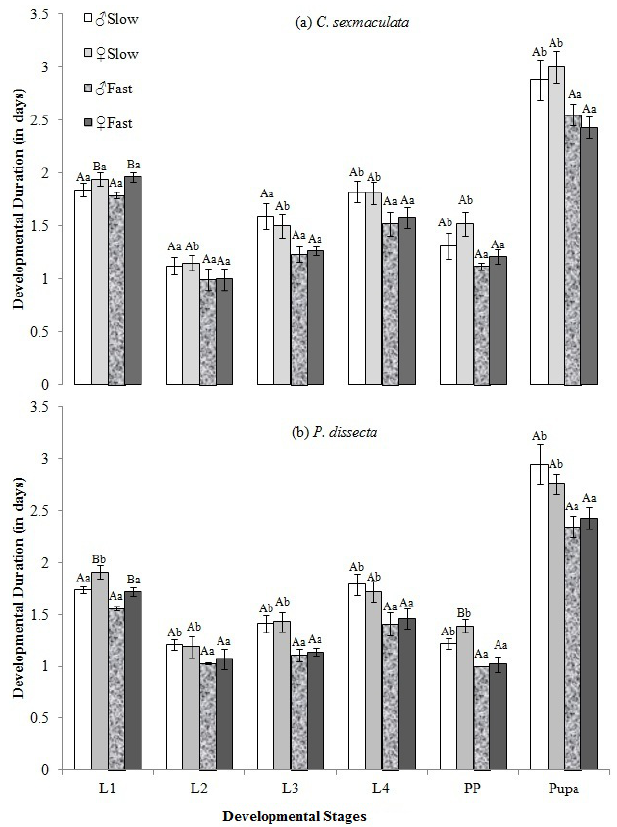
Figure 2. Durations of first (L1), second (L2), third (L3), fourth (L4) instars, prepupa (PP) and pupa in slow and fast developers of ladybirds C. sexmaculata and P. dissecta . Alphabets in upper case denote comparison between di ff erent sexes (male and female) of a developmental group (i.e. either slow or fast) within a species. Al- phabets in lower case denote comparison between same sexes (ei- ther males or females) of the two di ff erent developmental groups (slow and fast) within a species. Similar numbers or alphabets de- note lack of significance at P > 0 . 05.